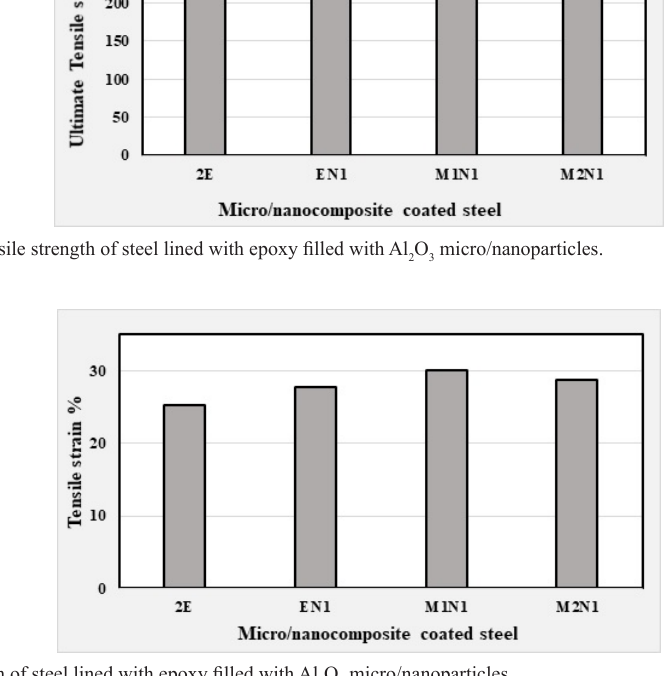
Figure 4. Tensile strain of steel lined with epoxy filled with Al